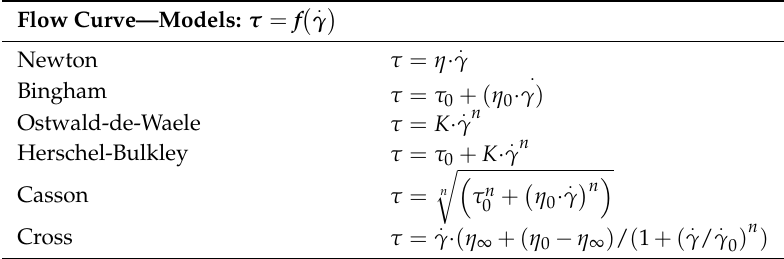
Table 1. Mathematical models for regression analysis. (cid:0) . (cid:1) Flow Curve—Models: τ = f γ . Newton τ = η ·